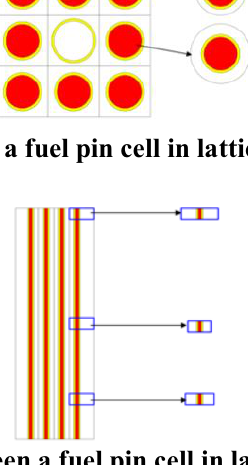
Figure 3. The Equivalence between a fuel pin cell in lattice and a 1D plate fuel pin